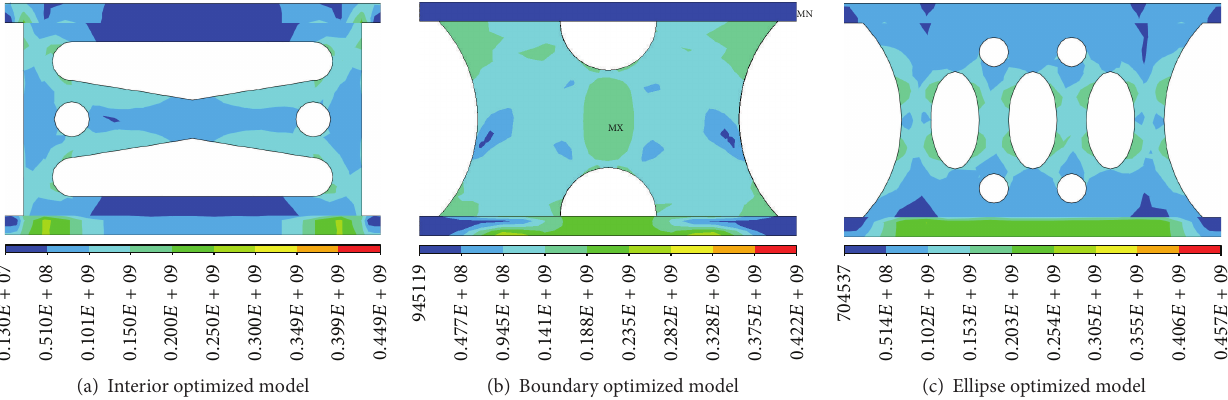
Figure 16: Stress nephogram of LY160 steel